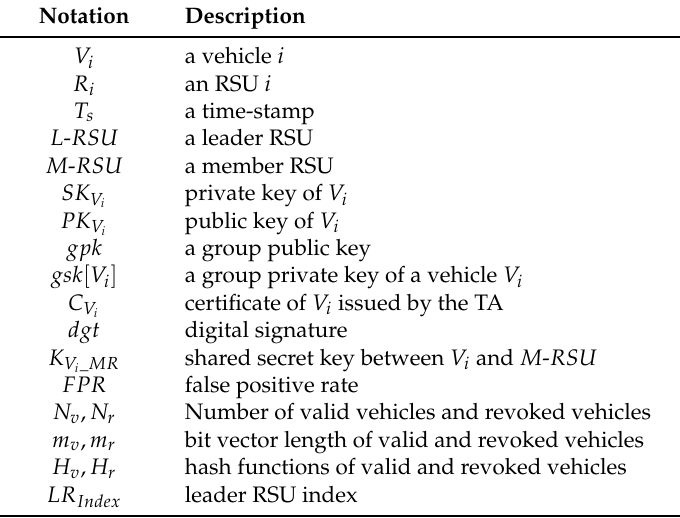
Table 1. Notations. TA, trusted